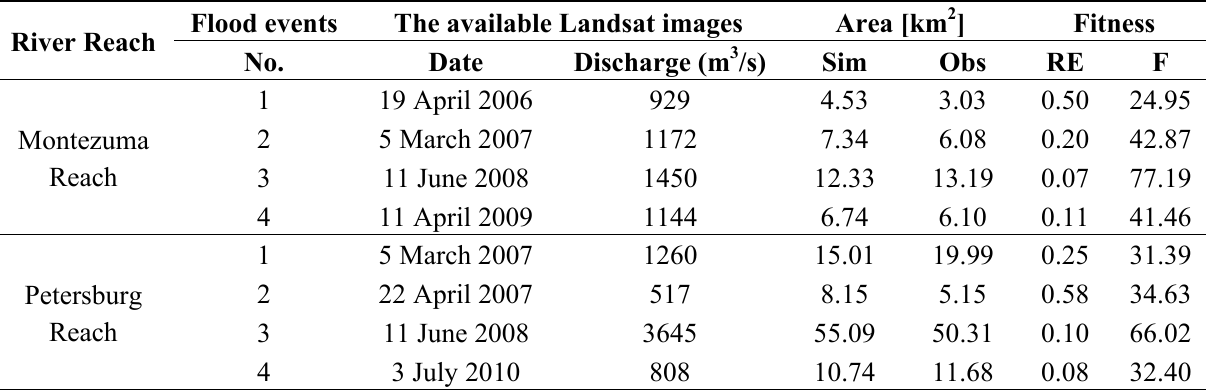
Table 3. Floodplain comparison